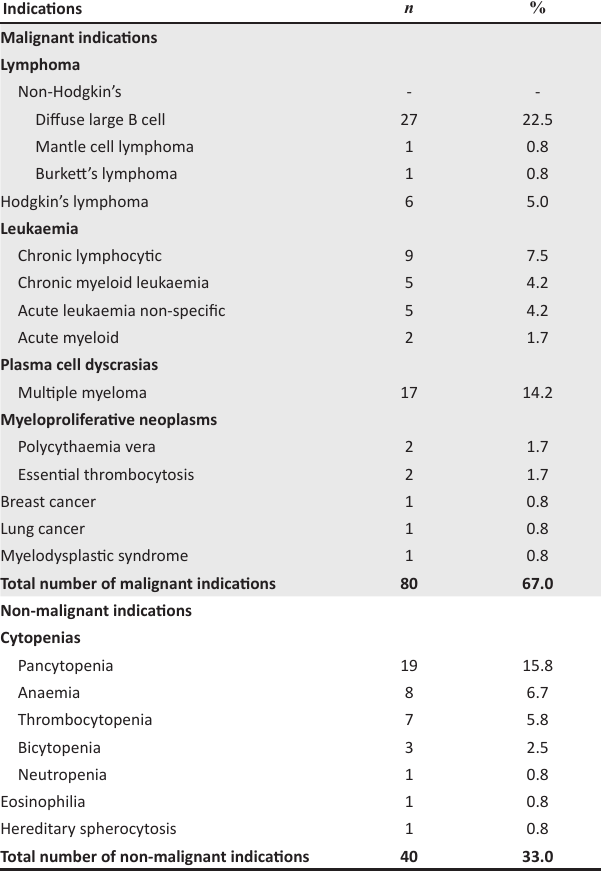
TABLE 1: Indications for performing bone marrow aspirate and trephine biopsies on an unselected group of 120 patients at a hospital in KwaZulu-Natal,